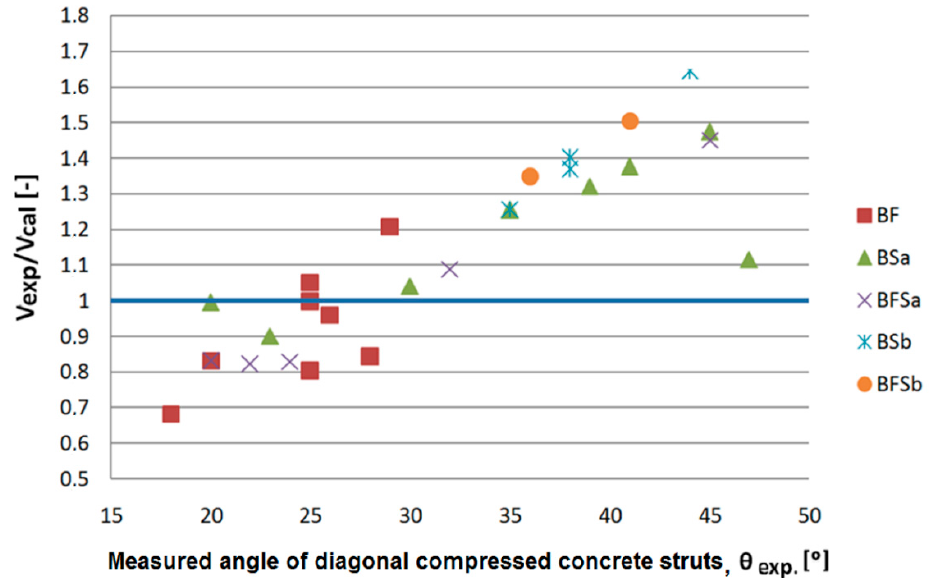
Figure 28. V exp /V cal values versus values of the measured angle of compression struts inclination (exp. θ ) obtained in the tests.